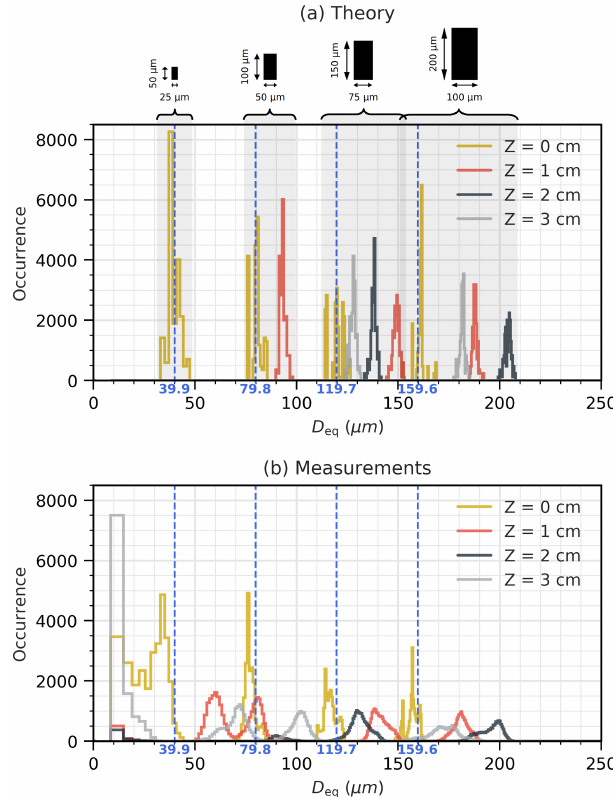
Figure 9. (a) Theoretical 2D-S D eq size distribution for opaque short columnar particles shown in Fig. 5. Each particle at each Z is simulated 19500 times with three orientations (0, 45, and 90 ◦ ) and with different positions over the photodiode array. Uncertainty is then due to diffraction and to the discrete pixel effect. (b) 2D-S size distribution for the same four short columnar particles imprinted with three orientations (0, 45, and 90 ◦ ) on the spinning